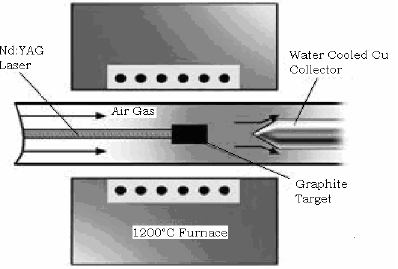
Figure 2 . Schematic drawing of a laser ablation